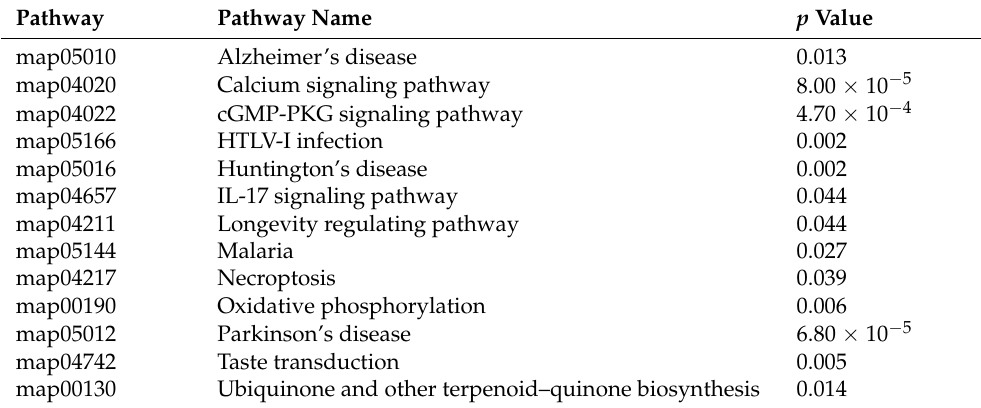
Table 6. KEGG pathway enrichment of differentially expressed proteins of 24 h vs. 6 h PM.